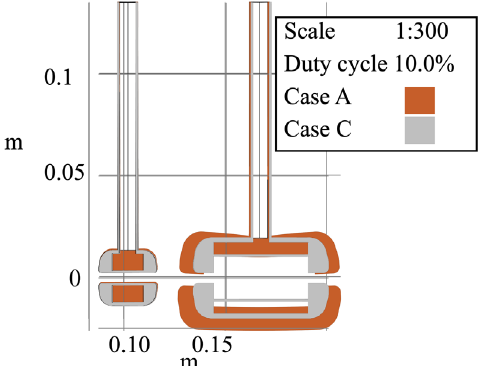
FIG. 9. The deformation of drift tubes at the duty cycle of 10%. Case A uses stem cooling in all drift tubes and case C uses drift- tube cooling. The deformation is scaled by a factor of 300 for better